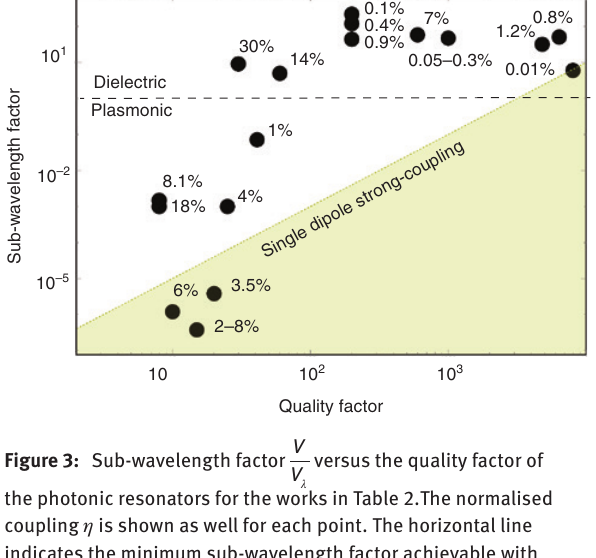
V versus the quality factor of Figure 3: Sub-wavelength factor V λ the photonic resonators for the works in Table 2.The normalised coupling η is shown as well for each point. The horizontal line indicates the minimum sub-wavelength factor achievable with dielectric structures ( ≈ 1). The dashed line represents the scaling of V in order to keep the condition of strong coupling with a single dipole ( N = 1) for a given f ≈ 1. Note that, at the top-right corner, the small η of InGaAs QD is compared with the almost ultrastrong coupling regime of single molecule at the left-bottom corner.